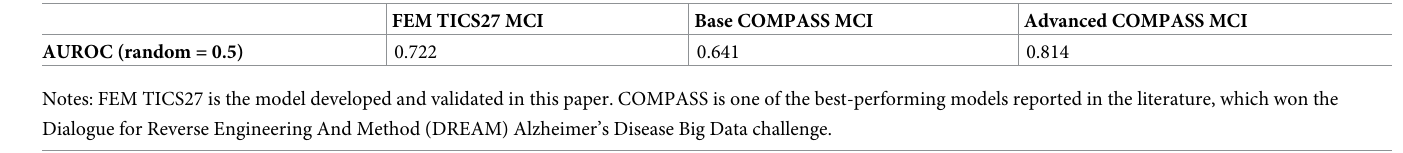
Table 7. Two-year TICS27 significant decline in MCI subjects and comparable results from COMPASS.